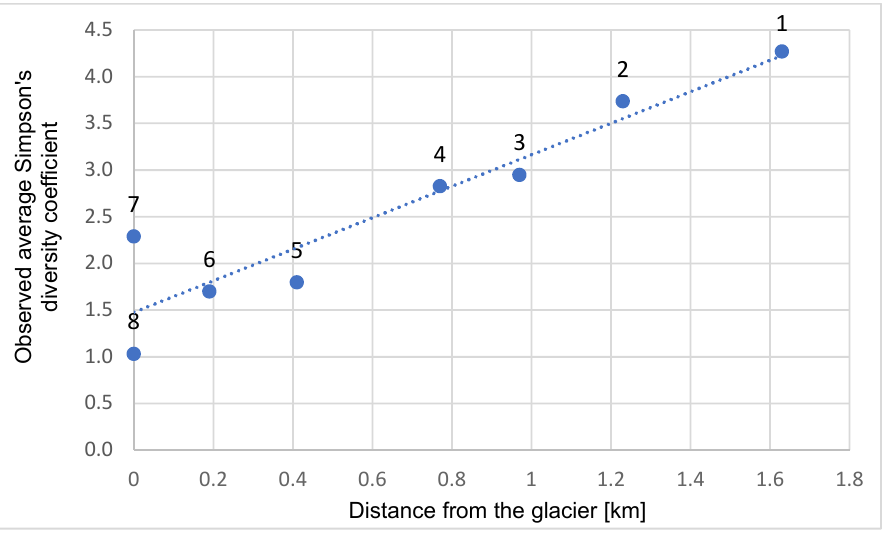
Figure 3. Observed average Simpson's diversity coefficient and linear regression.